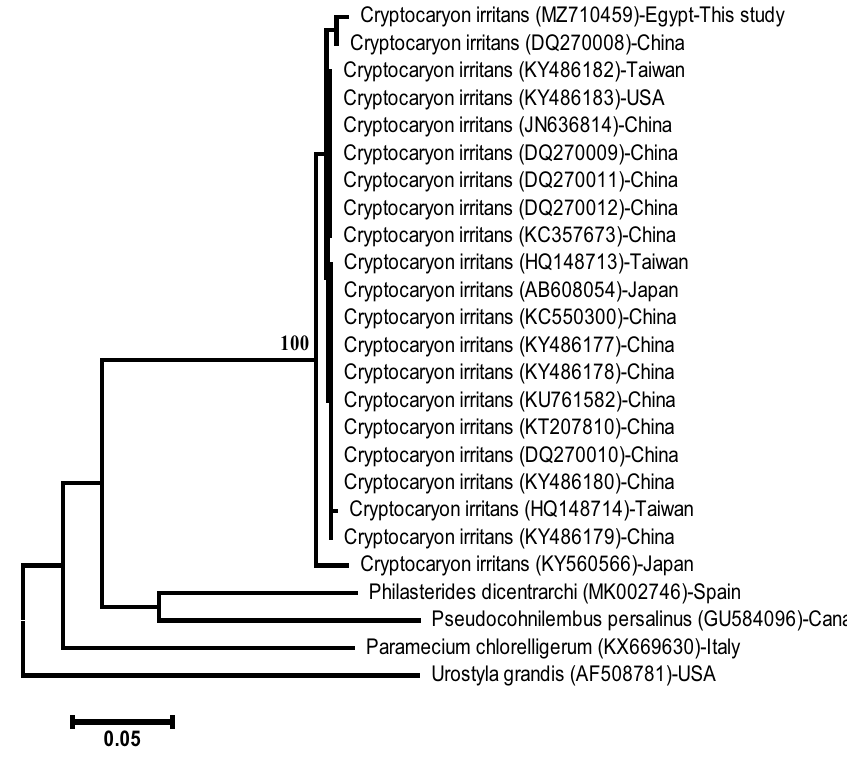
Figure 3. The neighbour-joining phylogenetic tree showed the comparative analysis of ITS rDNA sequence of C. irritans infecting L. carinata .